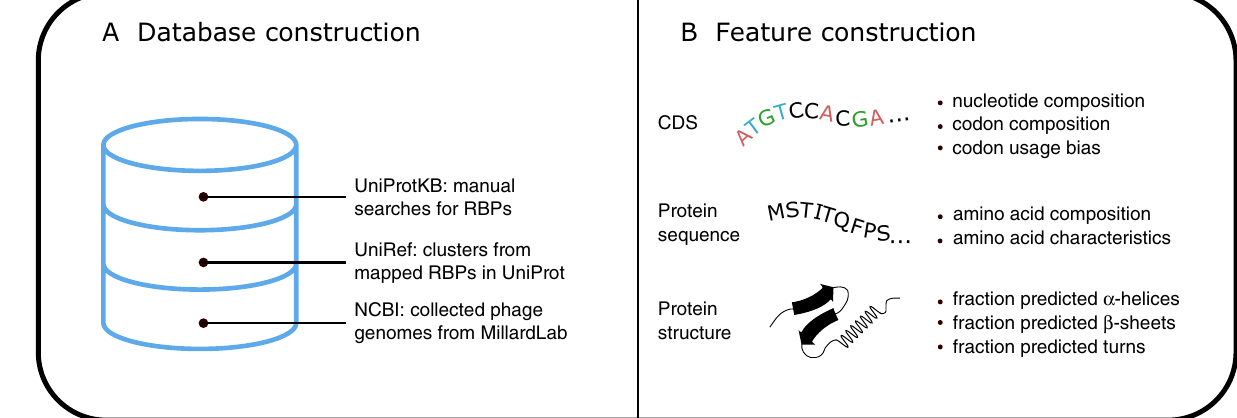
Figure 1. Graphical overview of database construction and feature construction. (A) Data were collected from three data sources: UniProtKB (via manual search), UniRef (via clusters that were mapped back to UniProtKB, May 2019) and collected phage genome data from MillardLab (www.milla rdlab .org, April 2019, downloaded via NCBI). (B) A total of 218 features (Supplementary Table S3) were constructed by collecting information from the coding DNA sequence (CDS), the protein sequence, and the protein